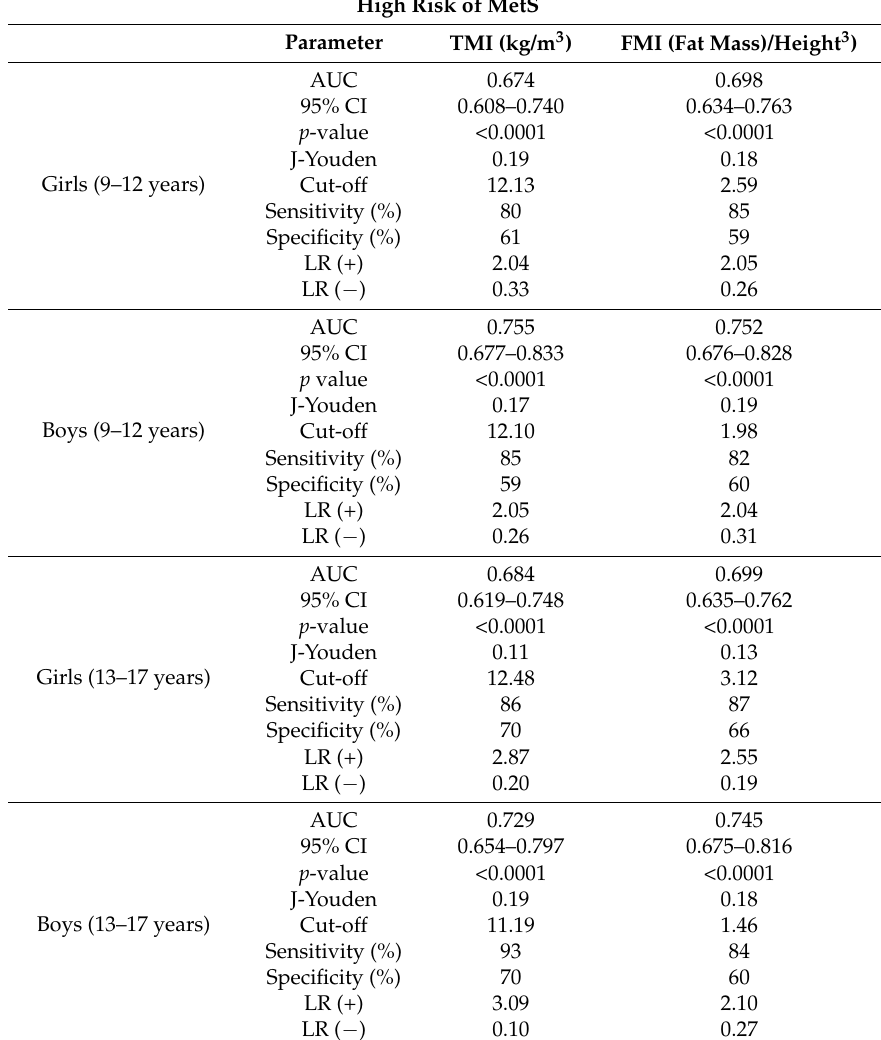
Table 3. Parameters of the receiver operating characteristic (ROC) curves analysis for the diagnostic performance of Tri-ponderal Mass (TMI) vs. fat mass index (FMI) in identifying high risk of metabolic syndrome (MetS) according to the Ferranti and Maggie criteria in children and